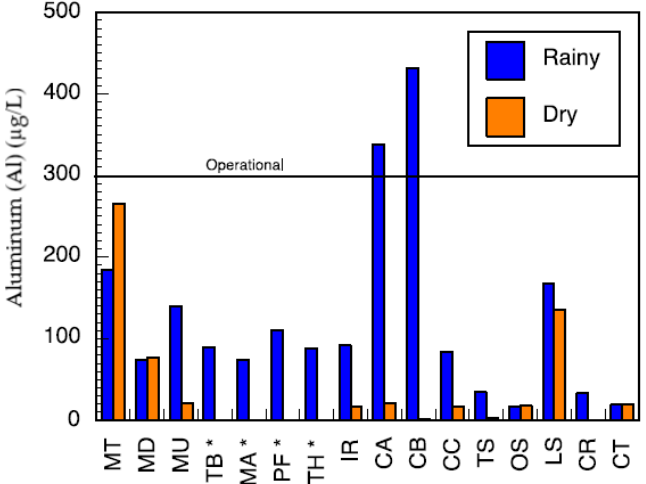
8 Figure 8. Aluminum, measured by an inductively coupled plasma mass spectrometer (ICP-MS), concentration for natural sources in the study area in the wet and dry seasons. The SANS 241 standard is shown (an operational standard is intended for treated water). Sources marked with * are intermittent sources and had no dry-season sample. Other sources have measured concentrations; although they may be too low to plot.